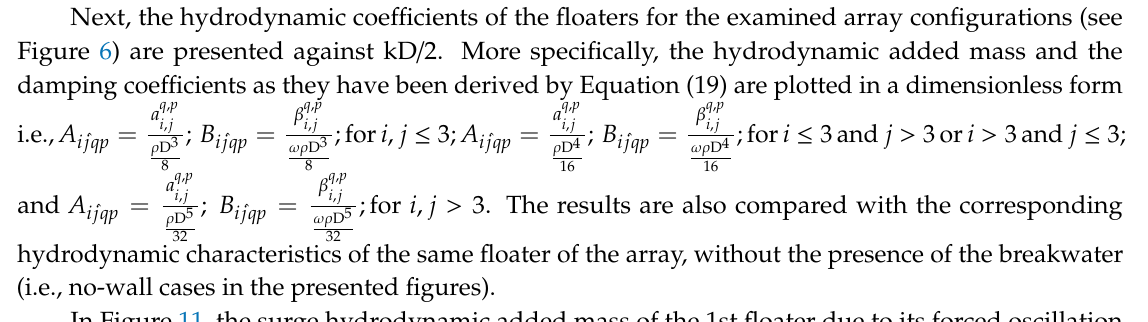
Figure 10. Dimensionless vertical exciting wave forces acting on the 3rd floater of the arrays against kD/2, for the three different examined array configurations. Comparison with the heave exciting wave forces on the same floater of the arrays without the presence of the breakwater: ( a ) parallel arrangement, C 1 ; ( b ) rectangular arrangement, C 2 ; ( c ) perpendicular arrangement, C 3 .